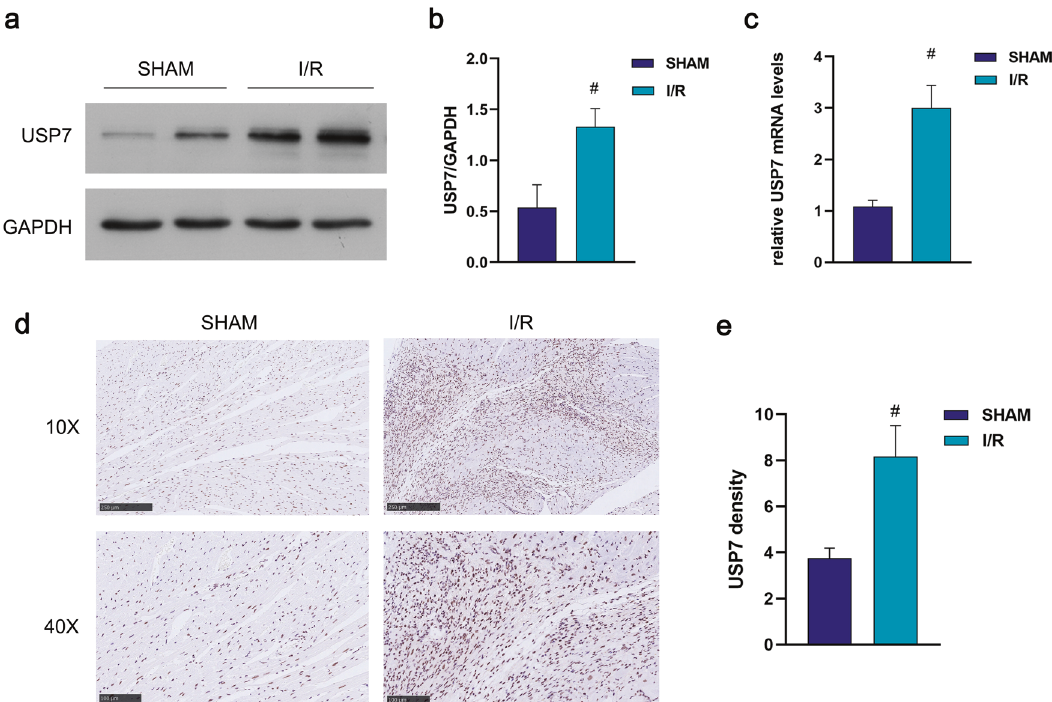
Fig. 2 Expression of USP7 in myocardial ischemia/reperfusion. a , b The cardiac tissue was collected after 30 min of ischemia and 2 h of reperfusion, then the protein expression of USP7 was detected by Western blot. c , d Immunohistochemistry. e RT-qPCR. # P < 0.05, mea ± standard deviation ( n ≥ 3), compared with the SHAM